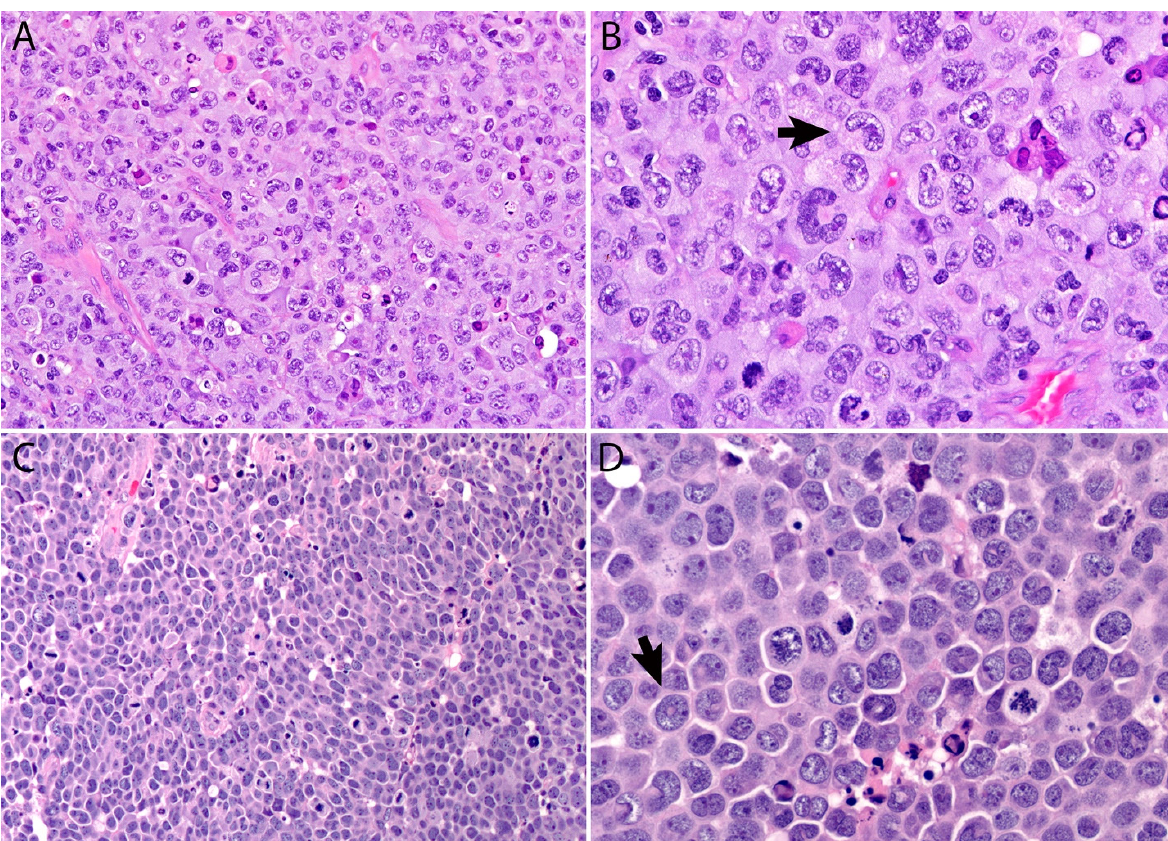
Figure 1. ( A , B ) ALCL is a neoplasm composed of sheets of large pleomorphic/anaplastic tumor cells with abundant cytoplasm. Occasional multinucleated cells and Reed-Sternberg-like cells are seen. ( B ) “Hallmark” cells are characteristic of this neoplasm (arrow). ( C , D ) Most cases of ALK- ALCL with the DUSP22 rearrangement have a more monotonous appearance and are less pleomorphic. This case has a particular starry-sky appearance. ( D ) Cells with central nuclear pseudoinclusions or a “doughnut” nuclear shape are commonly seen (arrow).